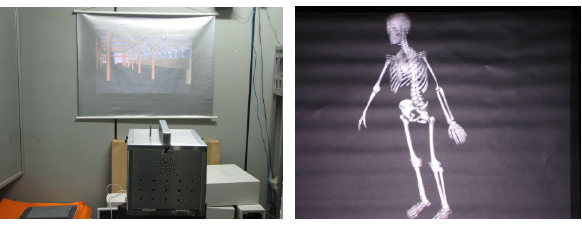
Figure 2. MiniVR working (left) and detail in dark environment (right)